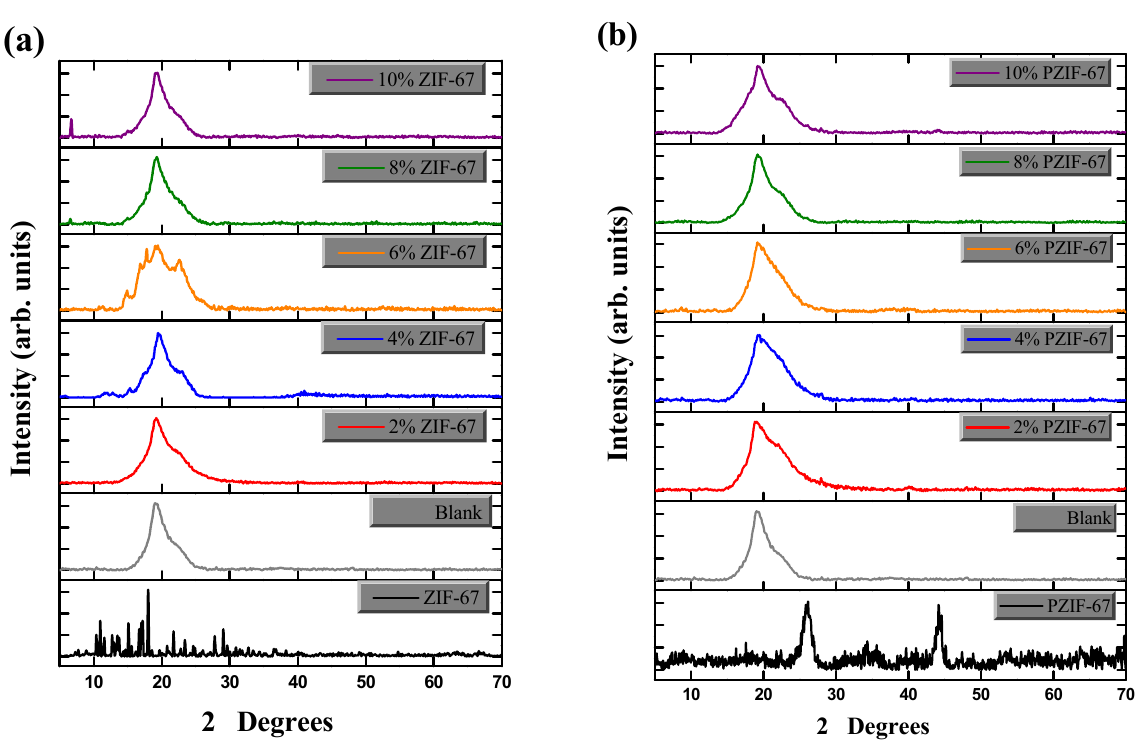
Figure 4. X-ray diffraction analysis of PVA/starch films. ( a ) Different compositions of ZIF-67 (0, 2, 6, 8, and 10%); ( b ) Various amount of Pyrolyzed ZIF-67 (0, 2, 4, 6, 8, and 10%).